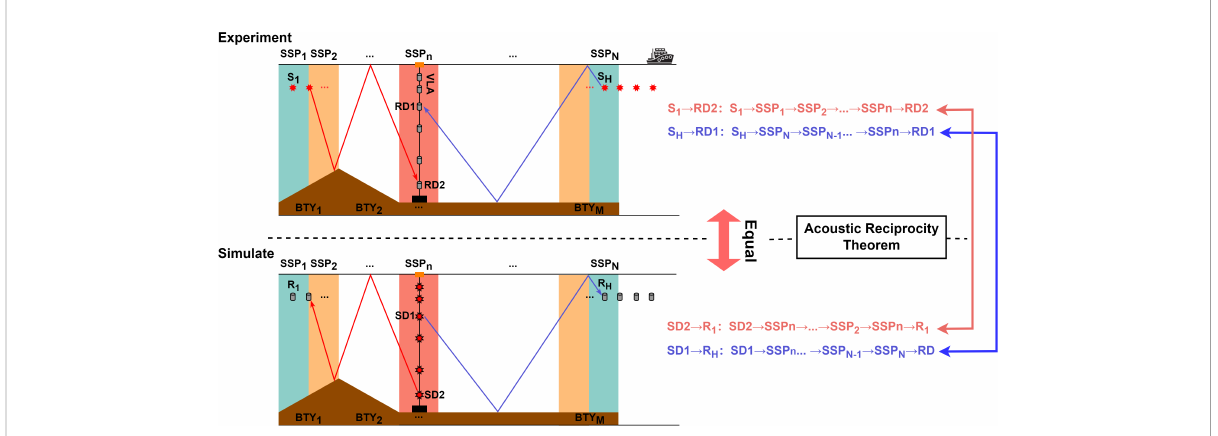
FIGURE 2 The diagram of acoustic reciprocity theorem of the fi eld experiment and simulation. The upper panel shows the position of the VLA (marked with grey cylinders) and the trajectory of the explosive sound sources (marked with red eight-pointed stars) with a fi xed explosive depth of 200 m. The colorful shaded areas represent range-dependent sound speeds in the presence of the warm eddy, and the brown shaded area represents the sea bottom. The red (blue) solid line indicates the sound ray launched from S 1 (S H ) and received by the RD2 (RD1) receiver. The lower panel shows the simulation con fi guration when analyzing the sound fi eld using 2D and 3D ray-tracing